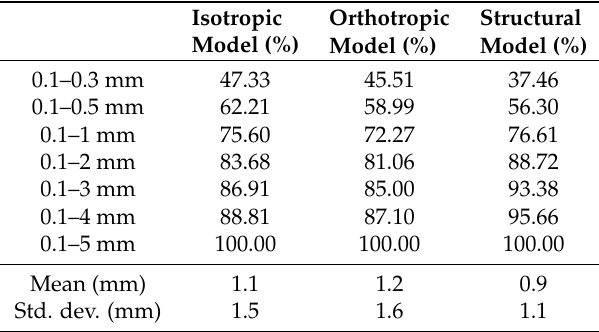
Table 4. Cumulative distribution of the cortical thickness for the hybrid isotropic, hybrid orthotropic and structural